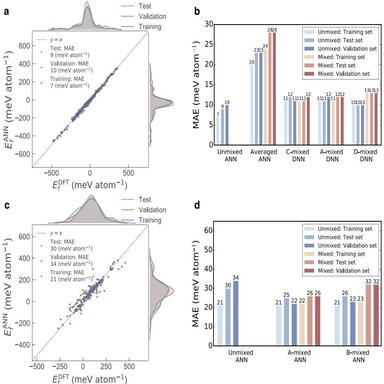
Plot of neural network-predicted formation energy Ef ANN against DFT-calculated formation energy Ef DFT for (a) unmixed garnets and (c) unmixed perovskites, and mean absolute errors (MAEs) in Ef in training, validation, and test sets of all (b) garnet and (d) perovskite models. Mixing is carried out on the 24c (C-mixed), 16a (A-mixed) and 24d (D-mixed) sites of the Ia d3¯ C3A2D3O12 garnet crystal, and the 4c (A-mixed) and 4d (B-mixed) sites of the Pnma ABO3 perovskite crystal. The similar MAEs for the mixed